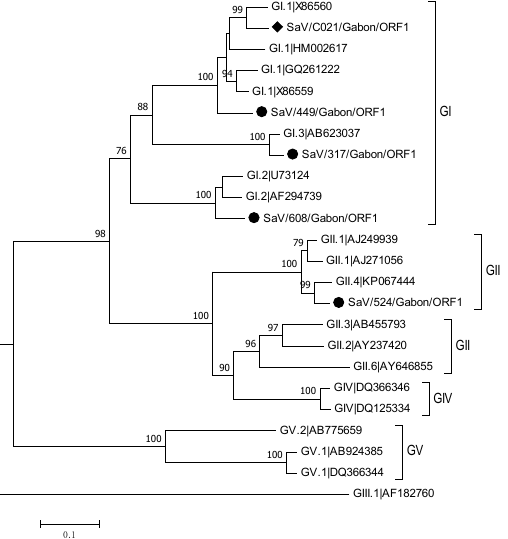
Figure 5. Phylogenetic tree of a 593 bp alignment of polymerase region (ORF1) of sapoviruses (SaV) strains from Gabon and SaV reference sequences (accession nos. are indicated). Samples from symptomatic patients are marked with a dot and samples from asymptomatic patients with a rhombus. The tree was constructed using the neighbor-joining method with the Bootstrap test (1000 replicates) and the Kimura 2-parameter method available in MEGA7. The bar indicates the nucleotide substitution per site.